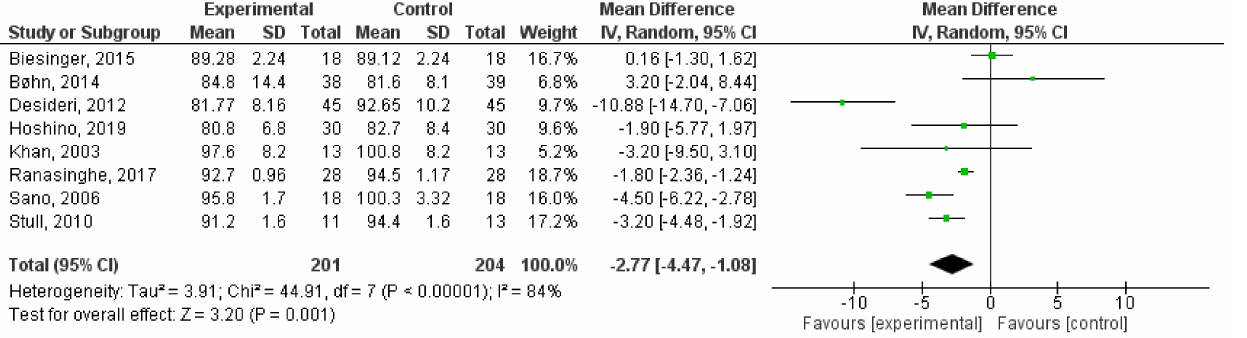
Figure 14. Forest plot representation of the effects derived from the supplementation of PACs on hematic sugar levels. Data were extrapolated from [177–184], and plotted according to the mean difference. Each horizontal line of the plot represents an individual study, reporting the punctual result plotted as green box. The weight of each study is represented by the size of the green box. The horizontal line indicates the lower and upper limit of the 95% Confidence Interval (CI) of the effect observed for each study. The vertical line represents the no-effect. For each study, if the horizontal line crosses the vertical one, a statistically significant difference between Experimental and Control group is not observed. The black diamond at the bottom of the forest plot represents the average effect size combining together the results of all the selected studies. The horizontal points of the diamond are the limits of the 95% CI of the average value. The figure was generated by Review Manager Software, version